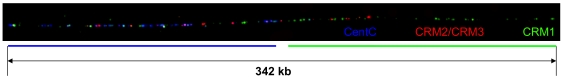
Fiber FISH map of a 342 kb region within the approximately 7 Mb B73 centromere 5.An oat-maize addition line for B73 chromosome 5 shows a predominantly CentC-containing region with interspersed CRMs that is flanked by a CRM1-rich region. CentC  =  blue, CRM1  =  green, CRM2/CRM3  =  red.